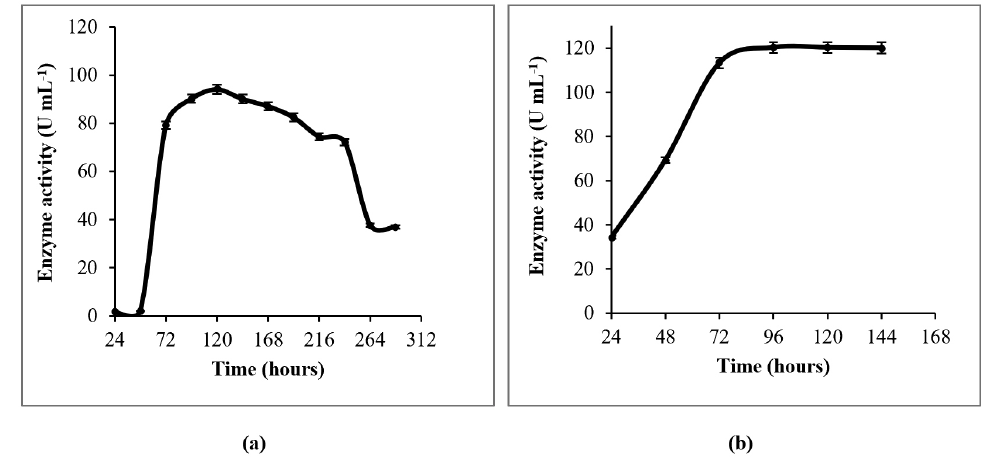
Fig. 4. Time course of L-asparaginase production in (a) SmF and in (b)